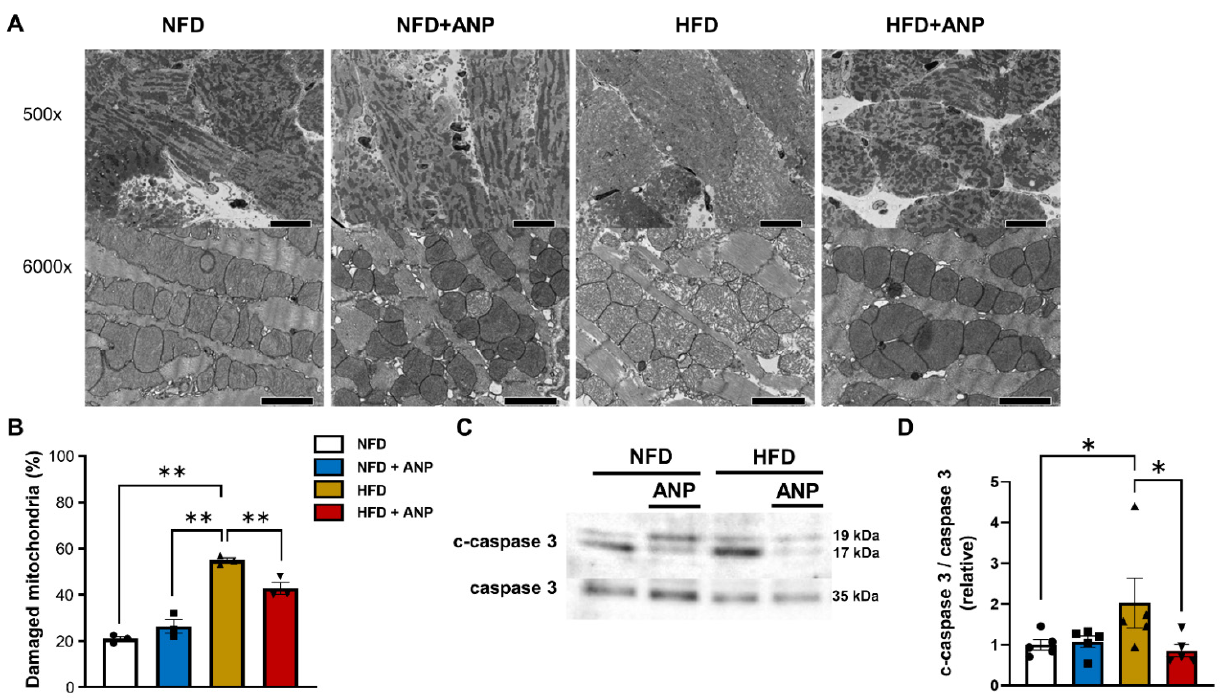
Figure 6. ANP treatment alleviated mitochondrial damage after IRI in HFD hearts. ( A ) Representative electron micrographs of heart sections after IRI with or without ANP. Each pair of electron micrographs displayed a set at lower magnification (top; scale bar, 2.0 μ m) and higher magnification (bottom; scale bar, 20.0 μ m). ( B ) Number of damaged mitochondria after IRI. ( C ) Representative immunoblots for cleaved and total caspase 3 from cardiac lysates after IRI. ( D ) Densitometric quantitation normalized to the level of cleaved/total caspase 3 expression in NFD hearts after IRI is shown (n = 5 each). * p < 0.05 and ** p < 0.01 versus HFD.